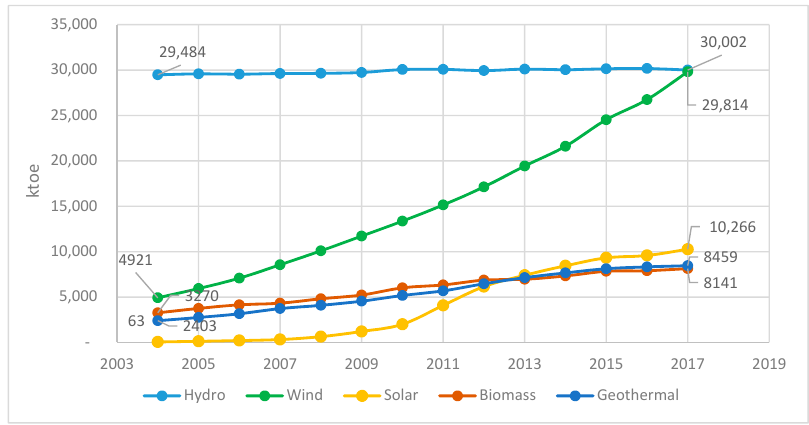
Figure 5. RES primary production in kilo tons of oil equivalent (KTOE), in EU member states, from 2004 to